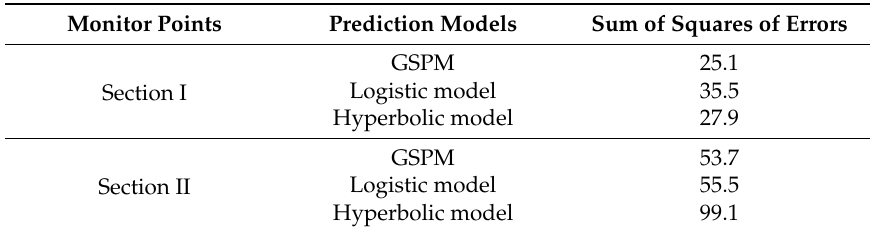
Table 6. Sum of squares of errors for different sections unit:mm 2 .